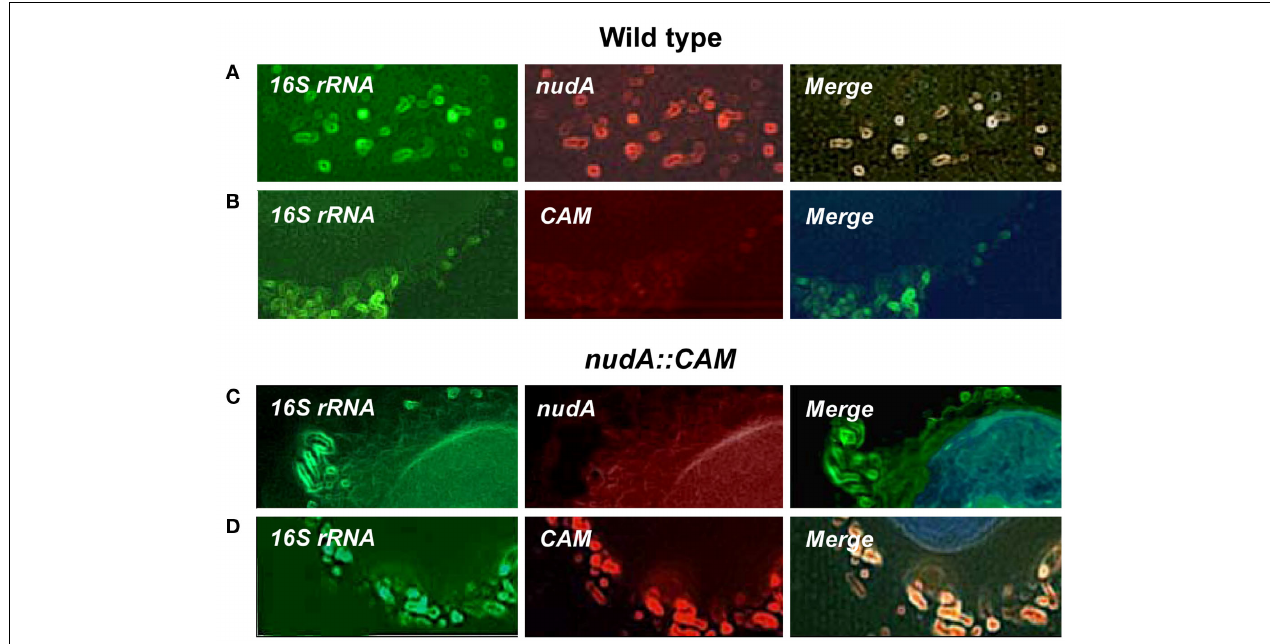
yellow, respectively). (B) 16S rRNA expression, no expression of CAM, and no merge. (C) 16S rRNA expression, no expression of nudA, and no merge. (D) 16S rRNA and CAM expression and complete merge of the two genes (green, red, and yellow, respectively). Original magnification: 1,000 ×